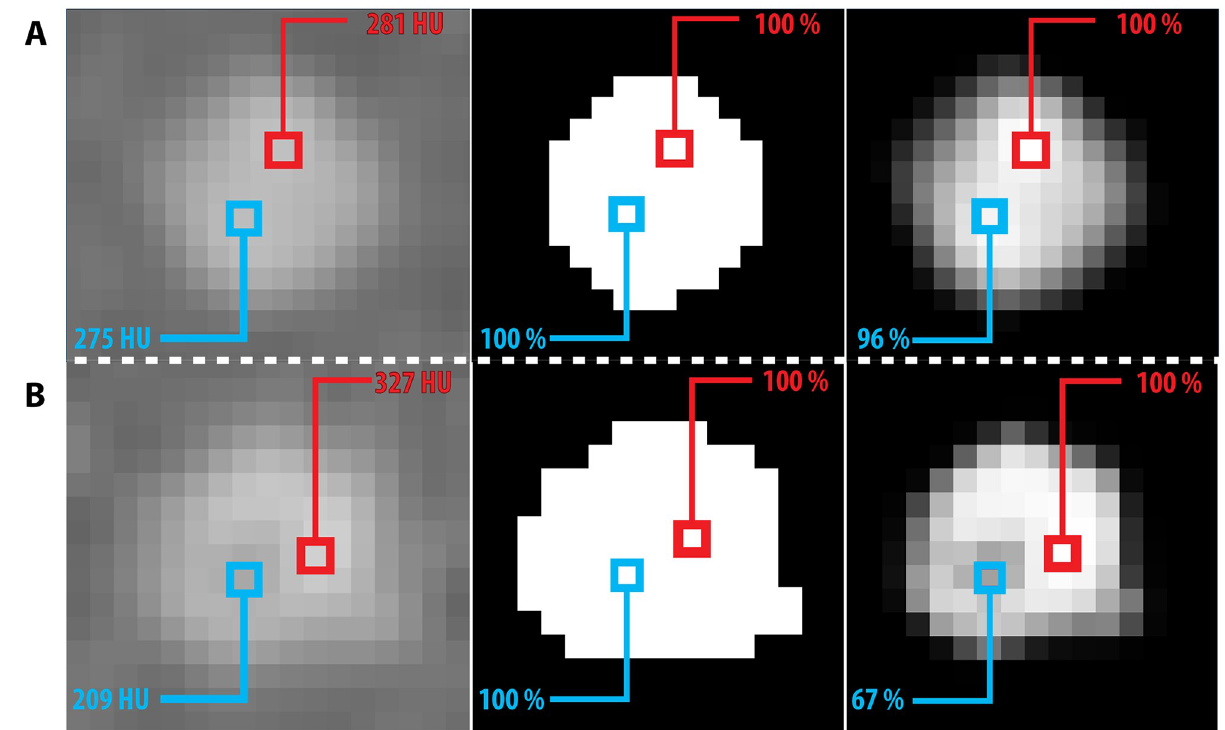
Fig 7. A: A CT slice showing values in a homogeneous CAC from the CEORA phantom; B: Unexpected large differences with respect to intensities in homogeneous CAC, which led to different probabilities calculated with PVC-CS; Left: Large CAC insert with HA density of 200 mg/cm 3 ; Middle: Segmentation obtained using C-CS; Right: Segmentation obtained using PVC-CS. Blue and red squares mark the same voxels in all images.